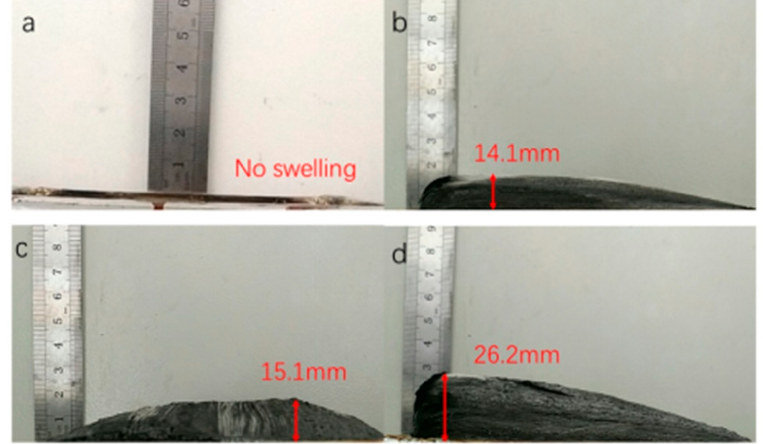
Figure 10. Side view digital photographs of residues after cone calorimeter testing, ( a ) CGF/PP ( b ) CGF/PP/20IFR/HPP ( c ) CGF/PP/25IFR/HPP ( d ) CGF/PP/30IFR/HPP.